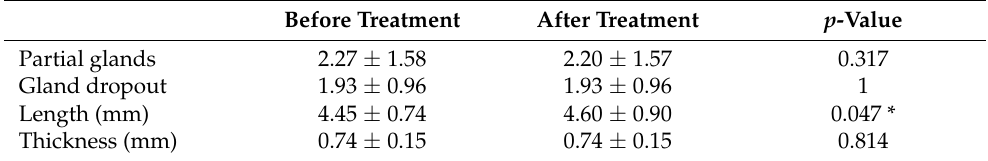
Table 4. Meibography before and after mechanical compression. (Analysis with entire dataset).